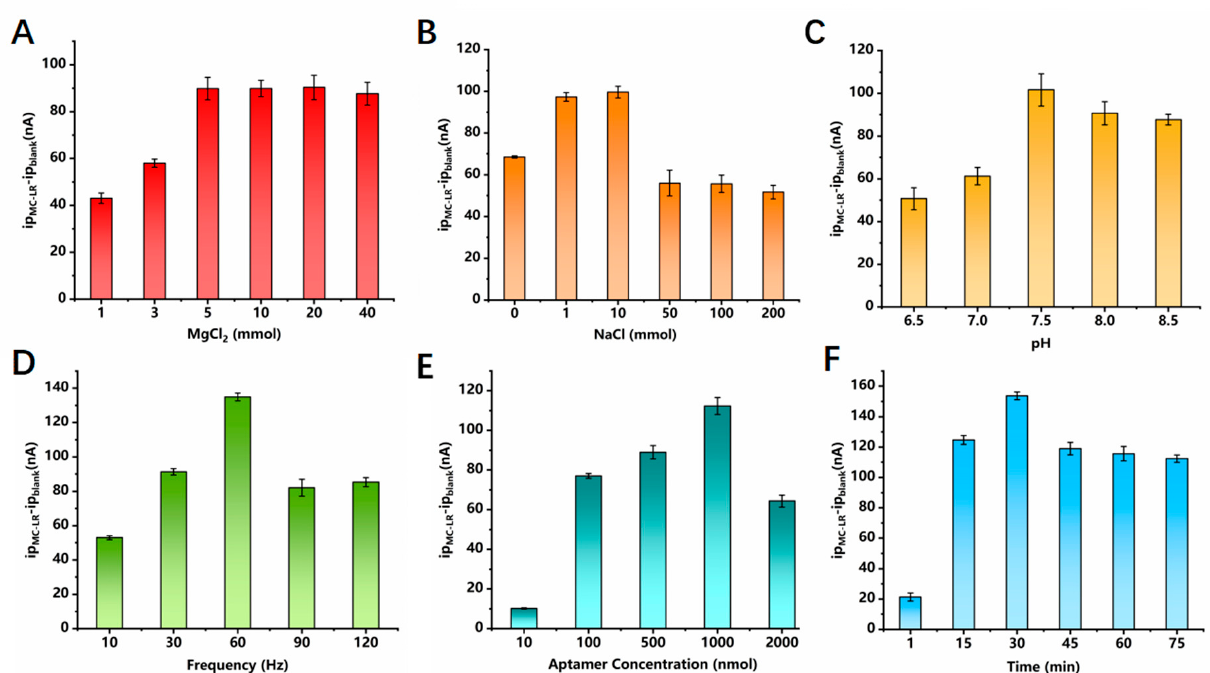
Figure 3. Optimization of the experimental conditions: ( A ) MgCl 2 concentration; ( B ) NaCl concentration; ( C ) pH value; ( D ) frequency; ( E ) aptamer concentration; ( F ) modification time. All conditions were tested with 100 ng/L MC − LR.